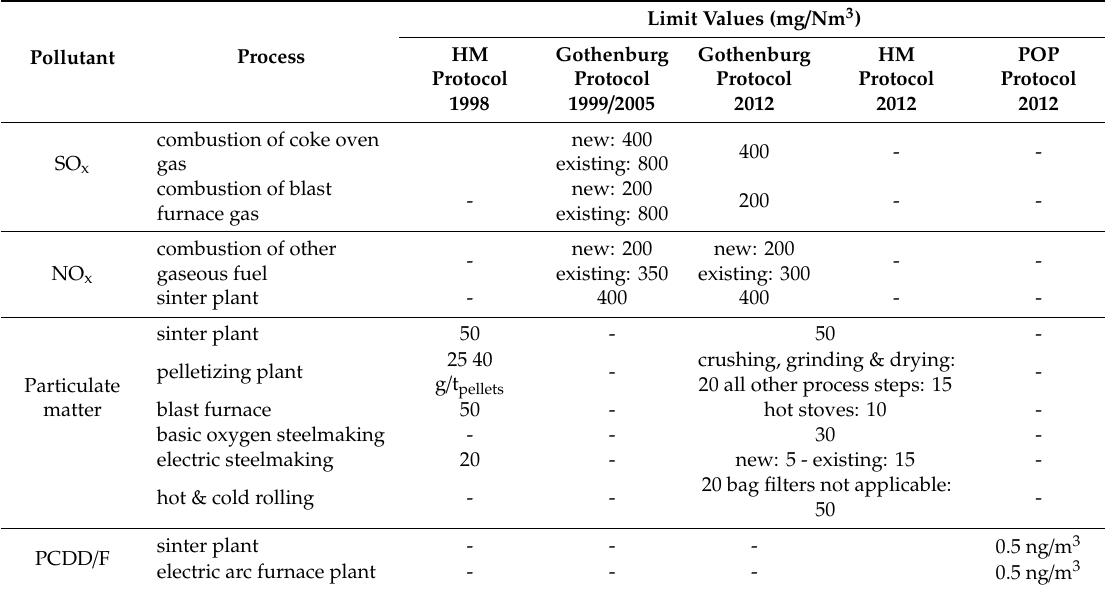
Table 2. Target values of various specific air emissions factors for steel production processes